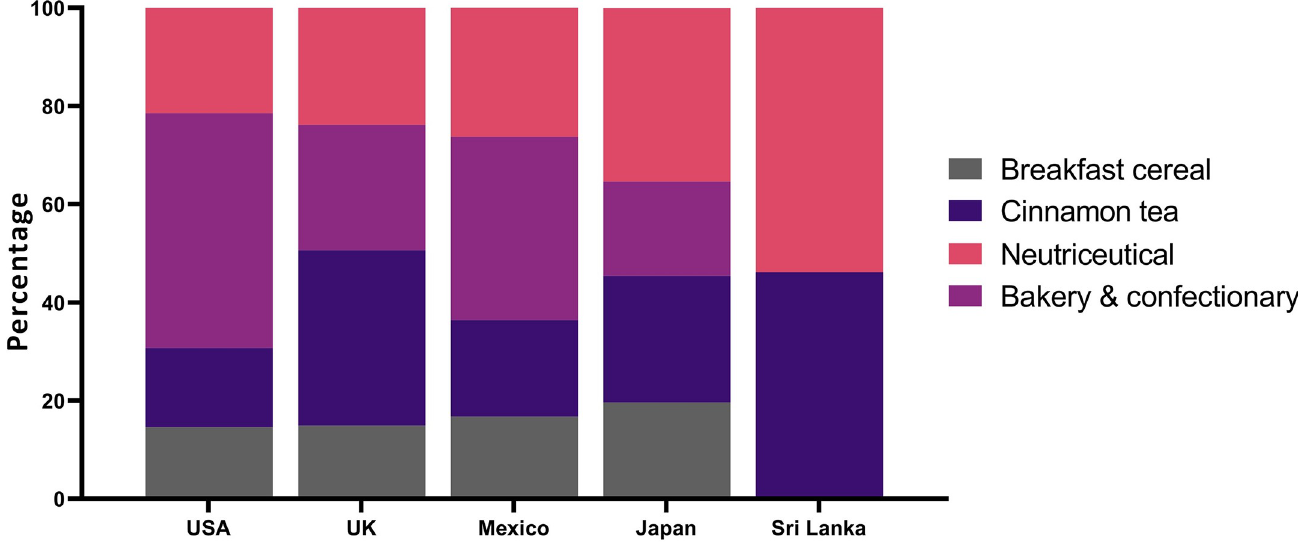
Fig 8. Clean label status of the cinnamon value-added retail products in the main markets. Bakery and confectionery of USA market, cinnamon tea of UK/EU market, bakery and confectionery of Mexican market, Nutraceuticals of Japanese and Sri Lankan exporters were recognized as the market with key clean labeled